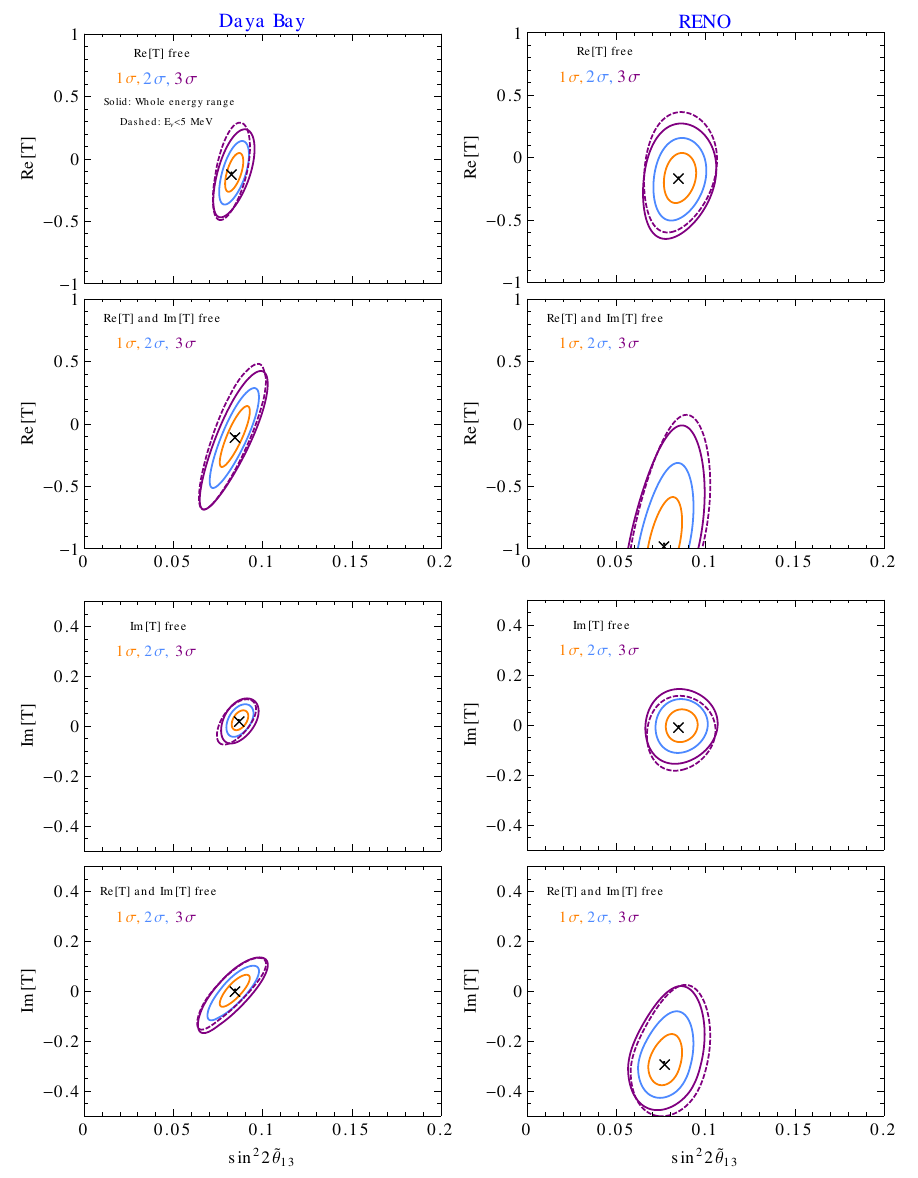
Figure 6 . Allowed regions in the (sin 2 2~ (cid:18) 13 (cid:0) Re [ T ]) ((cid:12)rst and second rows) and (sin 2 2~ (cid:18) 13 (cid:0) Im [ T ]) plane (third and fourth rows), for the Daya Bay (left) and RENO (right) experiments. The 1-, 2-, and 3- (cid:27) regions are shown with orange, blue, and purple, respectively. The best (cid:12)t values are marked by (cid:2) . The dashed curves correspond to the analysis where only events with E (cid:23) < 5 MeV are taken into account. We note that the y-axis range is di(cid:11)erent in the upper and lower panels.